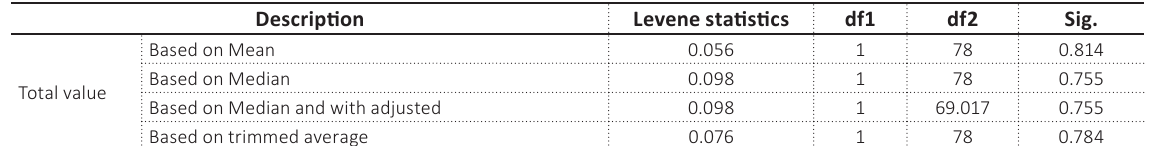
Table 7. Homogeneity test